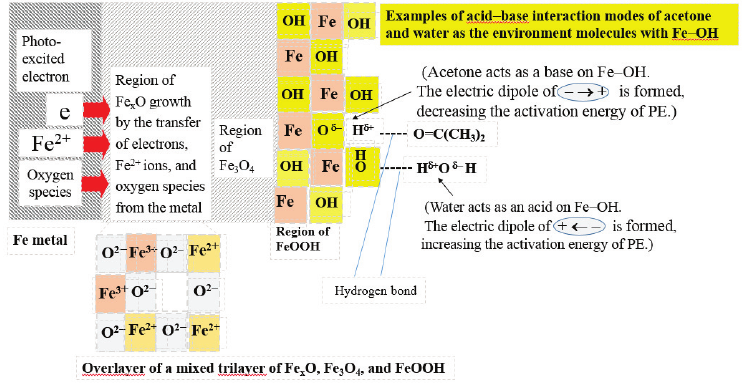
Figure 17. Growth of Fe x O p-type semiconductor and the acid–base interaction of the scratching environment molecule at the scratched surface as a result of the transfer of electrons, iron ions, and oxygen species from the metal during Up1 temperature scan. The electron density of the oxygen atom of Fe − OH is considered to become greater during the temperature scan.